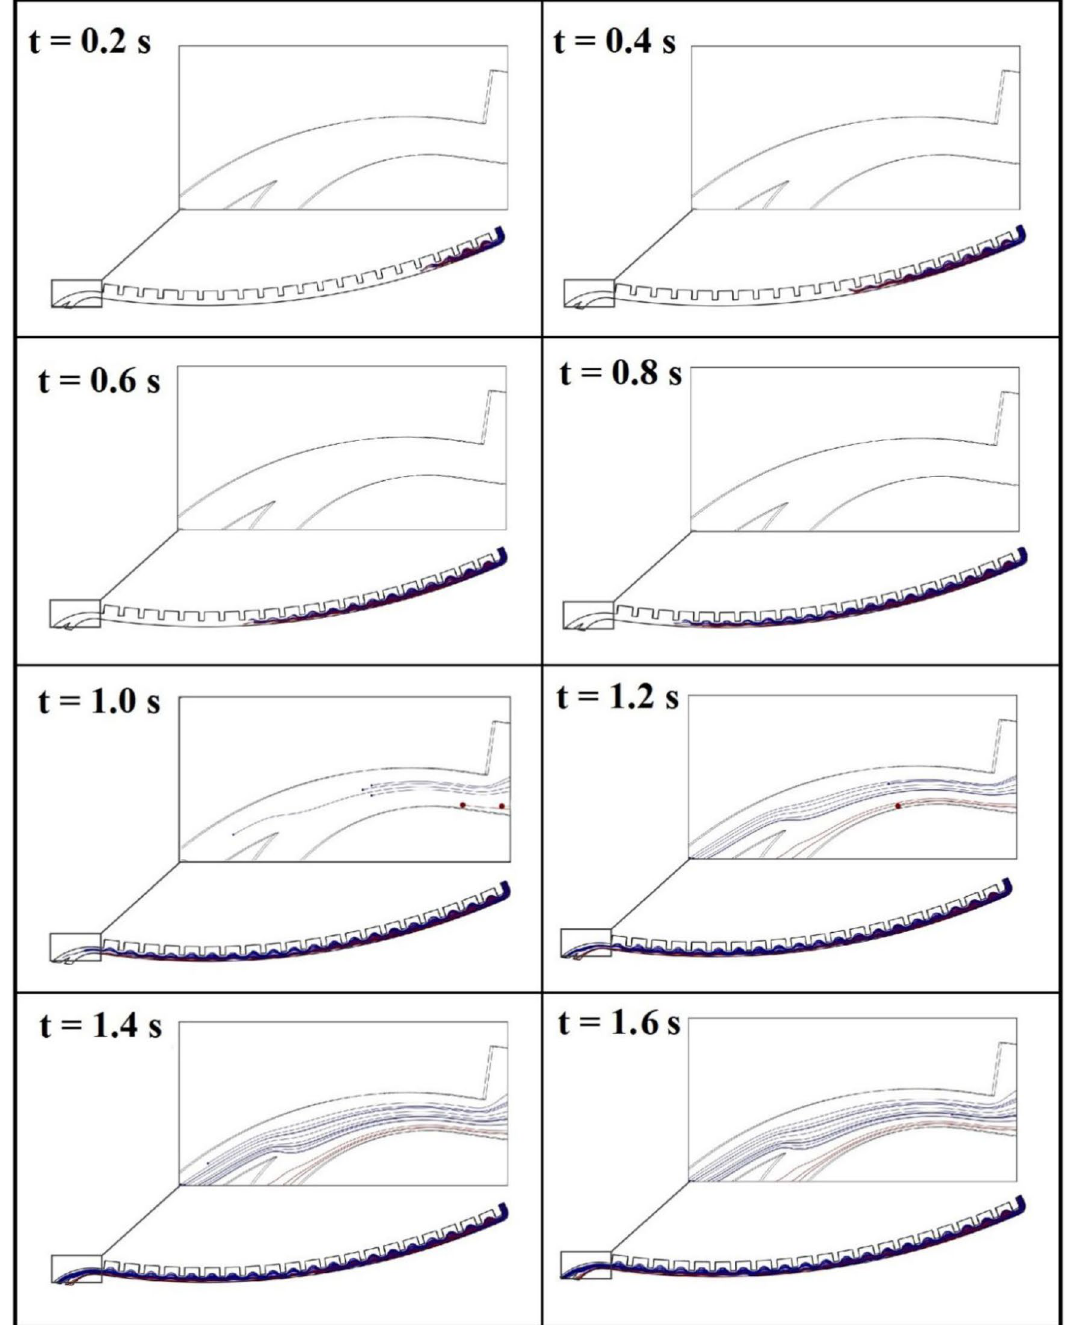
Figure 5. Simulated trajectories of 23 µm-particles (as MCF-7s) in red lines and 14 µm-particles (as L929s) in blue lines by using passive design of separator at the rotational speed of 2400